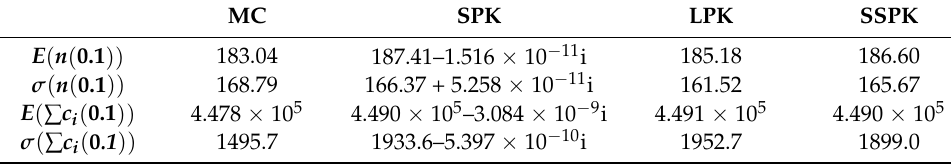
Figure 1. Population for the second case study. ( a ) Neutron population. ( b ) Precursor population. Table 3. Population for the second case study at time t = 0.1 s.